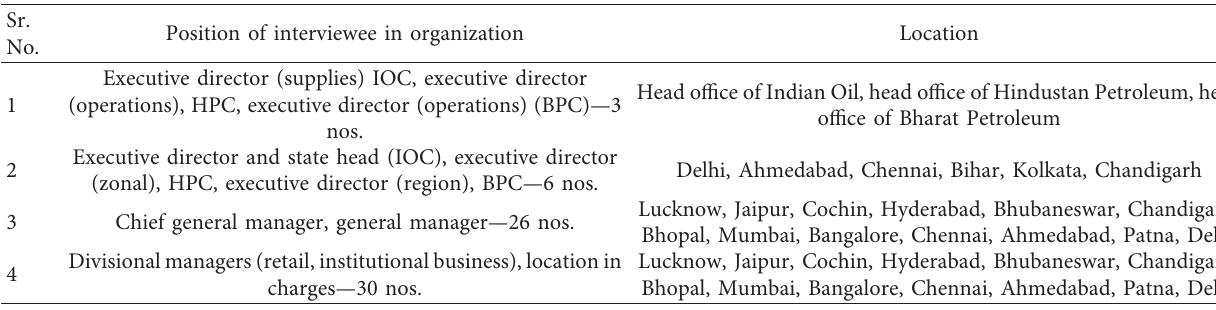
Figure 1: Data collection responses for survey 1. Table 1: Demographic profile of respondents for survey